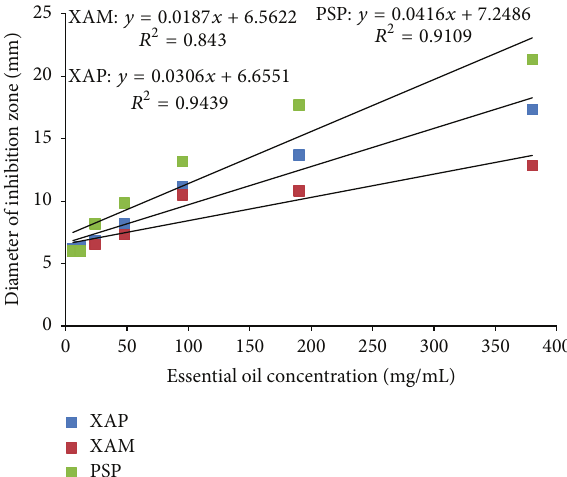
Figure 3: A dose-response curve of inhibition zone diameters (mm) against concentration of T. minuta essential oils (mg/mL) for the test bacteria. XAP: Xanthomonas axonopodis pv . phaseolicola ; XAM: Xanthomonas axonopodis pv . manihotis ; and PSP: Pseudomonas savastanoi pv .